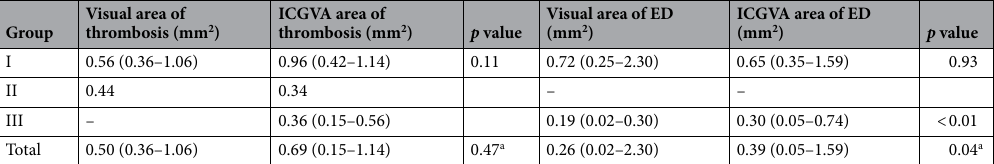
Table 2. Descriptive results of clinical ED area and thrombosis in visual and ICGVA analysis using NIH Image software (ImageJ 1.41o, National Institutes of Health, Bethesda, MD, USA). ICGVA Indocyanine